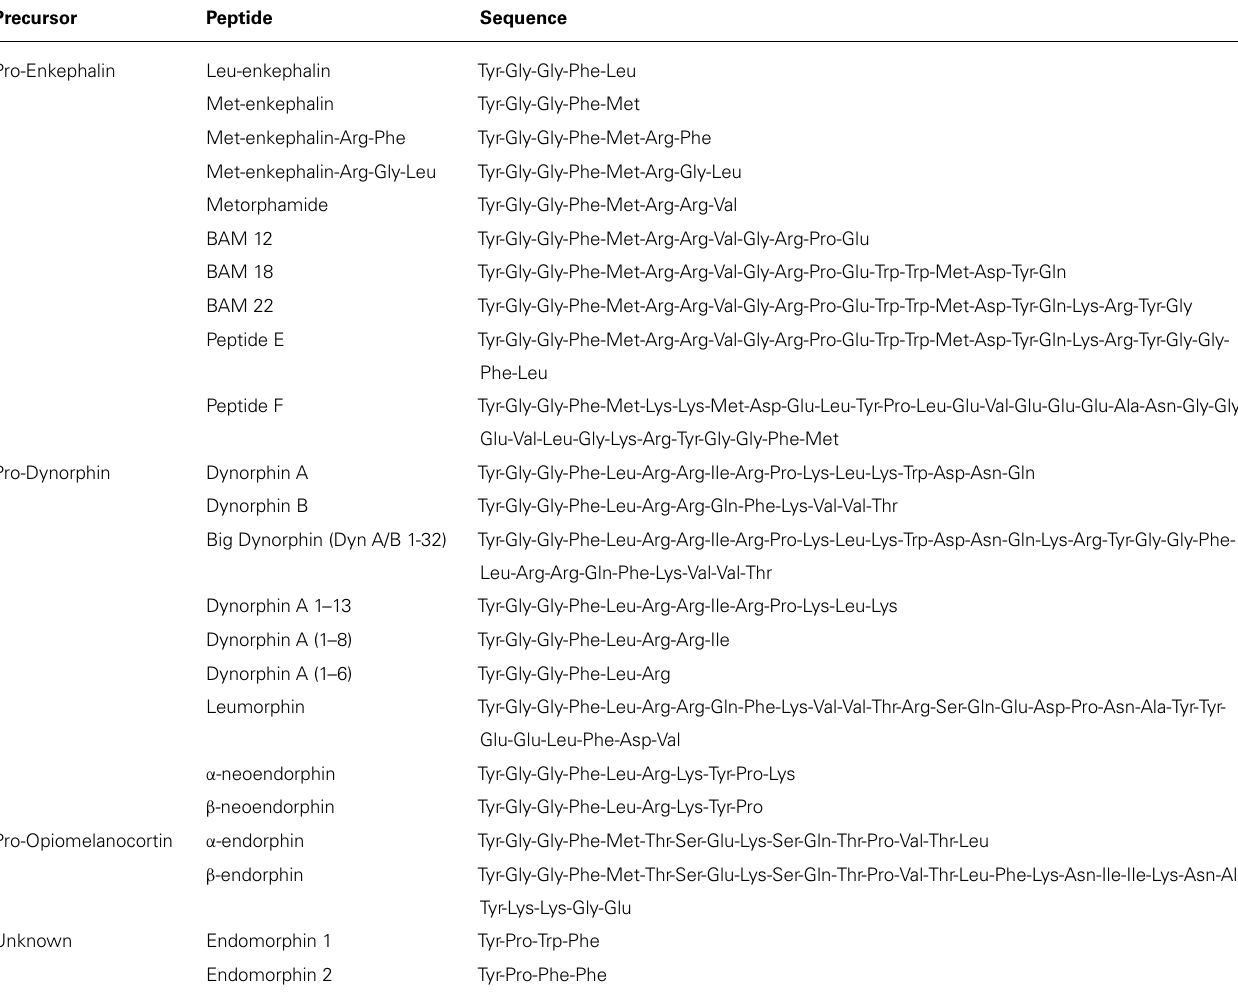
Table 2 | Endogenous opioid peptide